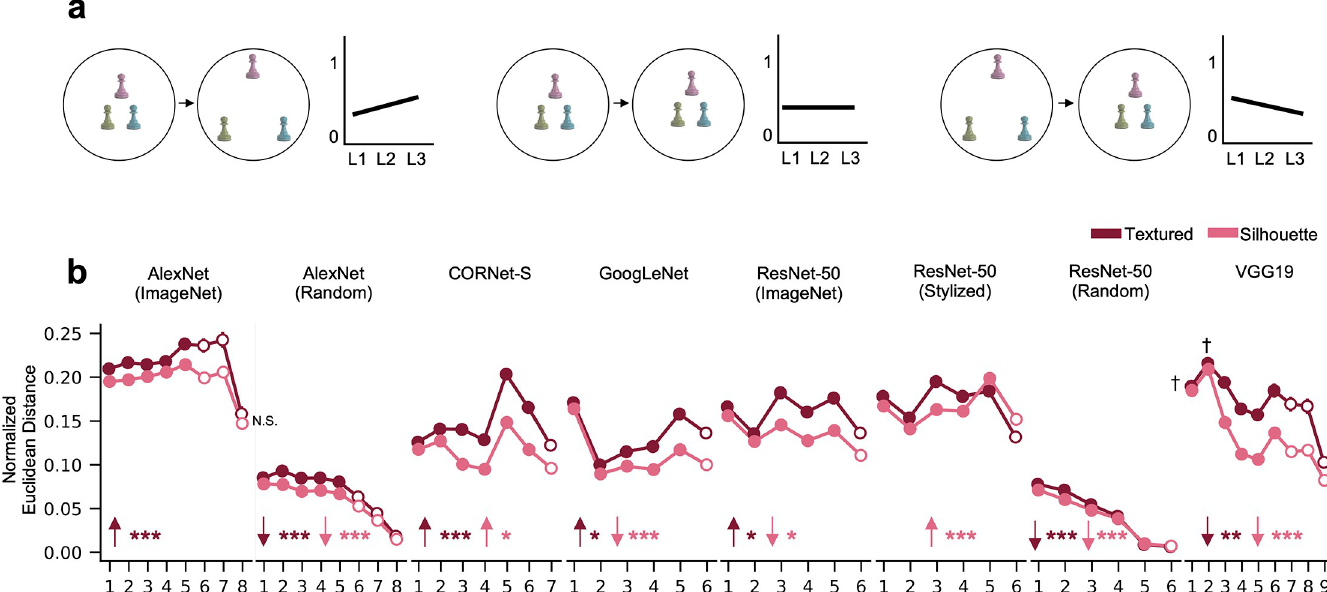
Fig 3. Magnitude of within-object color coding within each CNN layer. a. Schematic of three possible scenarios. In each scenario, the left figure illustrates the change in color space across two hypothetical CNN layers, with the distances among the same object in different colors reflecting the strength of color coding (with weaker and stronger coding corresponding to closer and more far apart arrangements, respectively). The right figure in each scenario illustrates how color coding strength may change across layers. Over the course of processing, color coding within an object can either grow more distinct (left panel), remain equally distinct (middle panel), or grow less distinct (right panel). b. Mean within-object color distances for each object. Results for the random networks are averaged across 100 random initializations. Fully-connected layers are marked by hollow circles and other types of layers sampled are marked by solid circles. Regression analyses were conducted to test for an aggregate increase or decrease in color representation over the course of processing; upward- and downward-facing arrows denote a significant increase or decrease respectively, with the level of significance denoted by the adjacent asterisks. Pairwise comparisons between the textured and silhouette stimuli were conducted for every layer; since a significant difference was found in every layer but a few, only the non-significant or trending layers are denoted. Different networks exhibit heterogeneity in how the strength of color coding varies across processing; however, the textured stimuli generally exhibit higher within-object color distances than the silhouette stimuli, and the untrained random networks ��� p < .001, �� p < .01, � p < .05, † p < .1, N.S. =